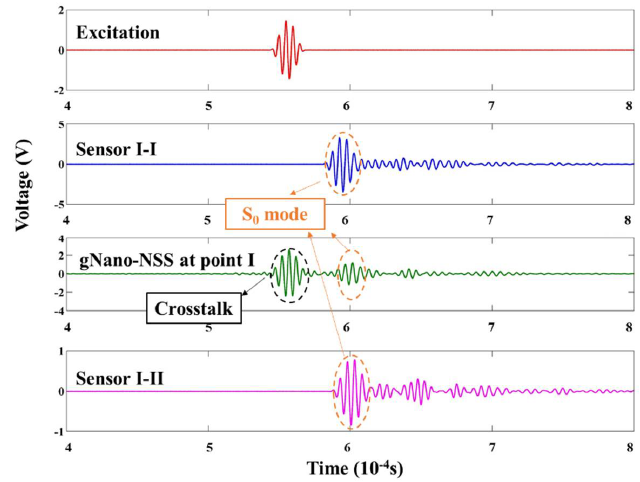
Figure 12. Raw UGW signals captured by the gNano-NSS of the composite and counterpart PZT sensors at point I.